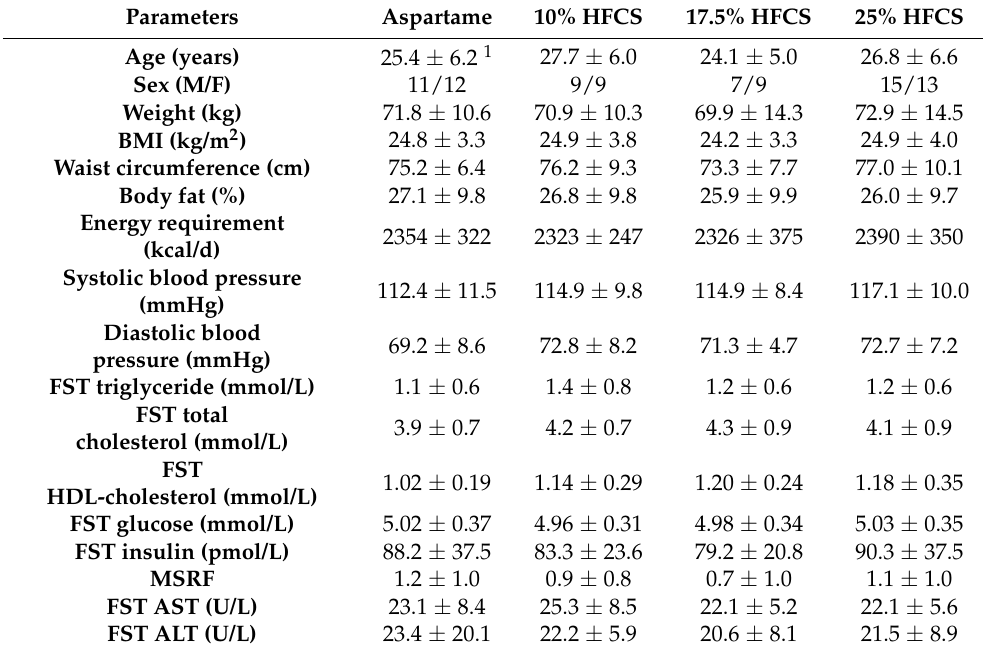
Table 1. Participants’ characteristics at